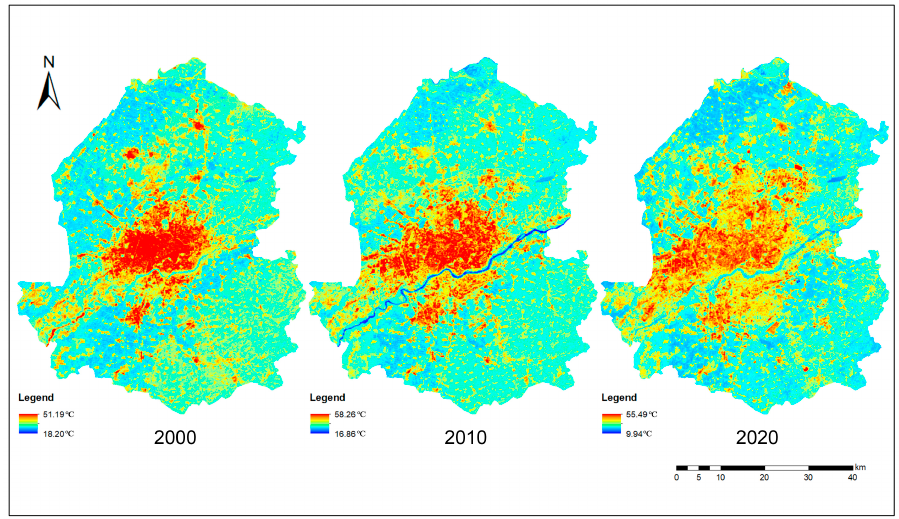
Figure 4. Spatial distribution of and temporal changes in LST in Shenyang in 2000, 2010 and 2020.